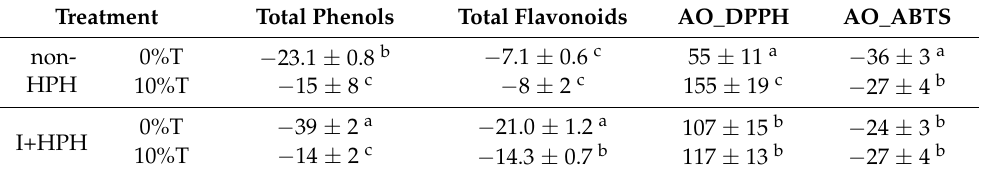
Figure 5. Antioxidant properties of clementine juice fermented with L. salivarius spp. salivarius CECT 4063 in cold storage for 30 days. Error bars represent the standard deviation of 4 replications. For each antioxidant property, a–d in the same time and A–F in the same series indicate statistically significant difference with a 95% confidence level ( p < 0.05). Table 3. Percentage of increase (values > 0) or decrease (values < 0) in the antioxidant properties under-gone by 24 h-fermented clementine juices stored for 15 days at 4 ◦ C.